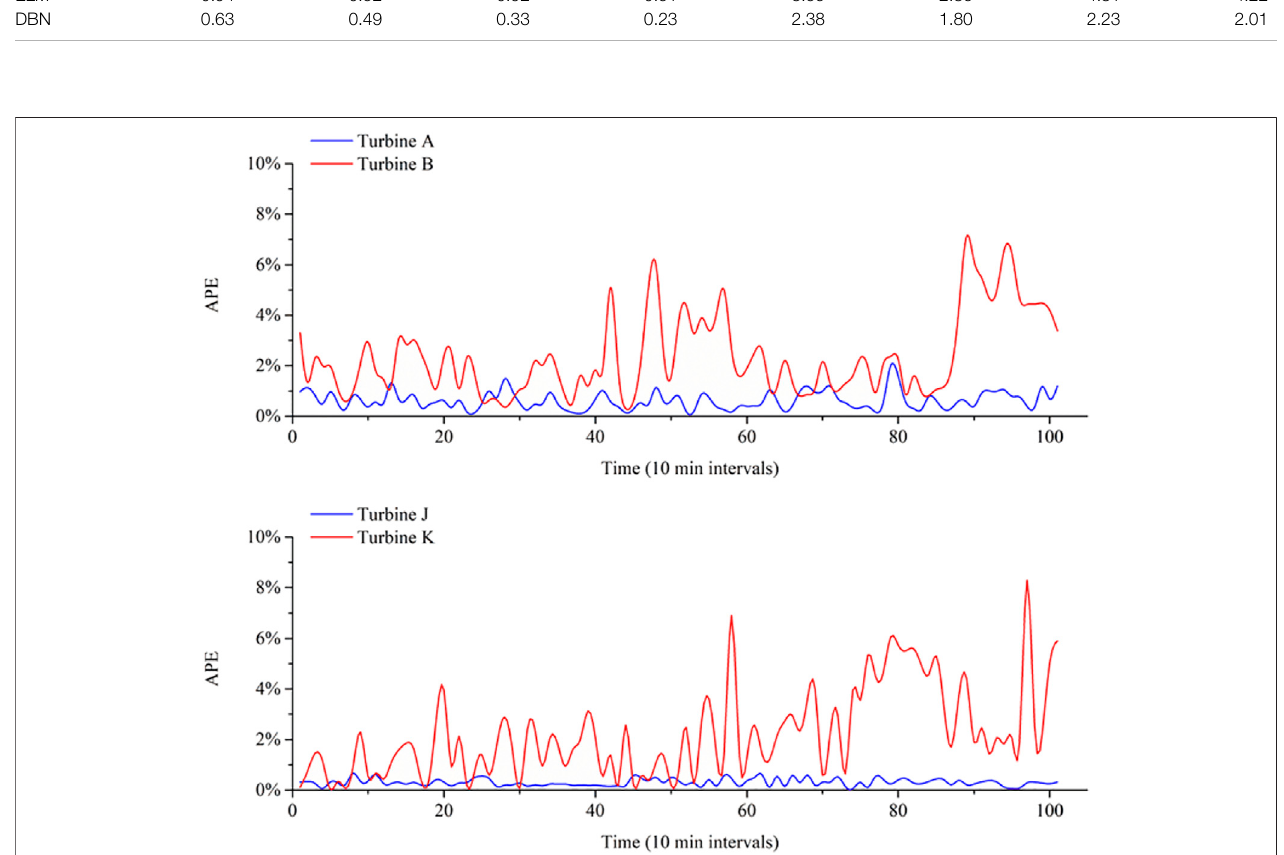
FIGURE 4 | The absolute percentage error produced by the deep belief